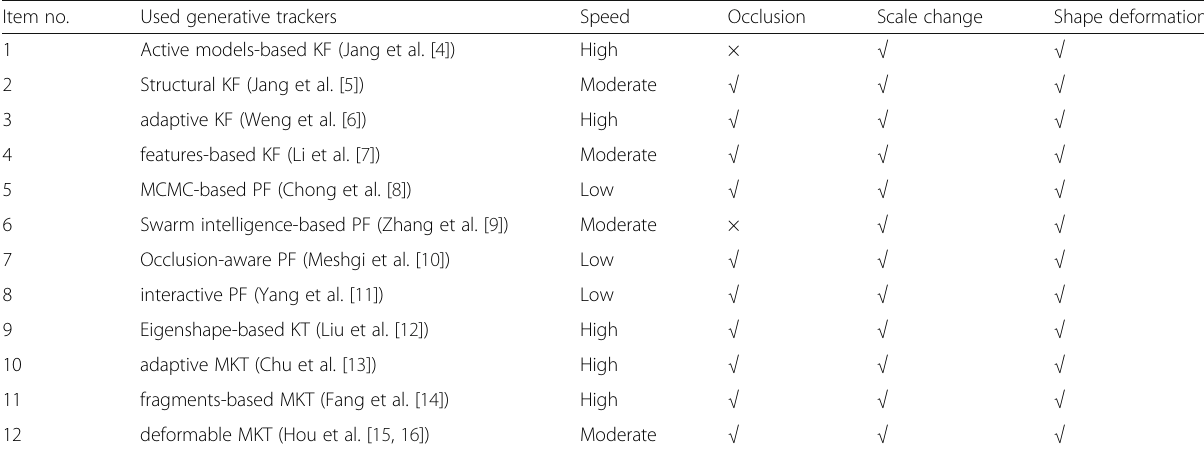
Table 2 Qualitative comparison of generative trackers-based human tracking within a camera Item